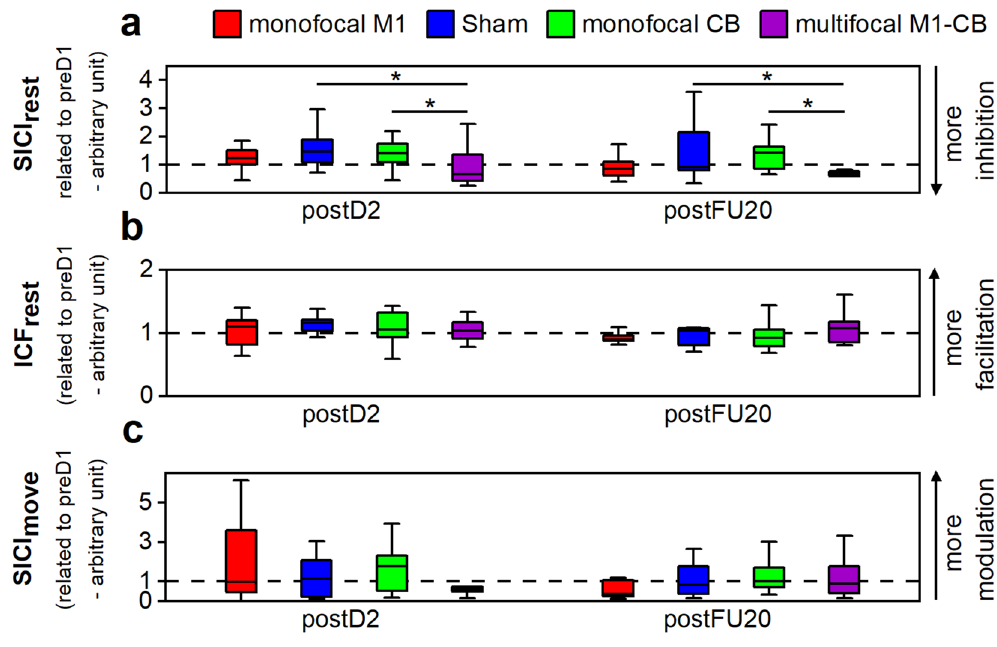
Figure 4. Paired-pulse TMS assessments. postD2, after training day 2; postFU20, after follow-up day 20. Red, monofocal M1 group; blue, sham group; green, monofocal CB group; violet, multifocal M1-CB group. Box plots depict median (solid vertical line), box bounds (upper to lower quartile), whisker (range within 1.5 interquartile range). Values are related to baseline by computing the ratio between postD2 and preD1, respectively postFU20 and preD1. ( a ) SICI rest related to baseline (preD1), * depicts p < 0.05 for post hoc mean-separation testing across significant main effect CONDITION applying a Tukey adjustment. The SICI rest data was log-transformed for statistical analysis to meet the normality of residuals assumption. ( b ) ICF rest related to baseline (preD1). ( c ) SICI move modulation, expressed as absolute value of the delta between 90 and 20% of reaction time (RT) datapoints, related to baseline (preD1).